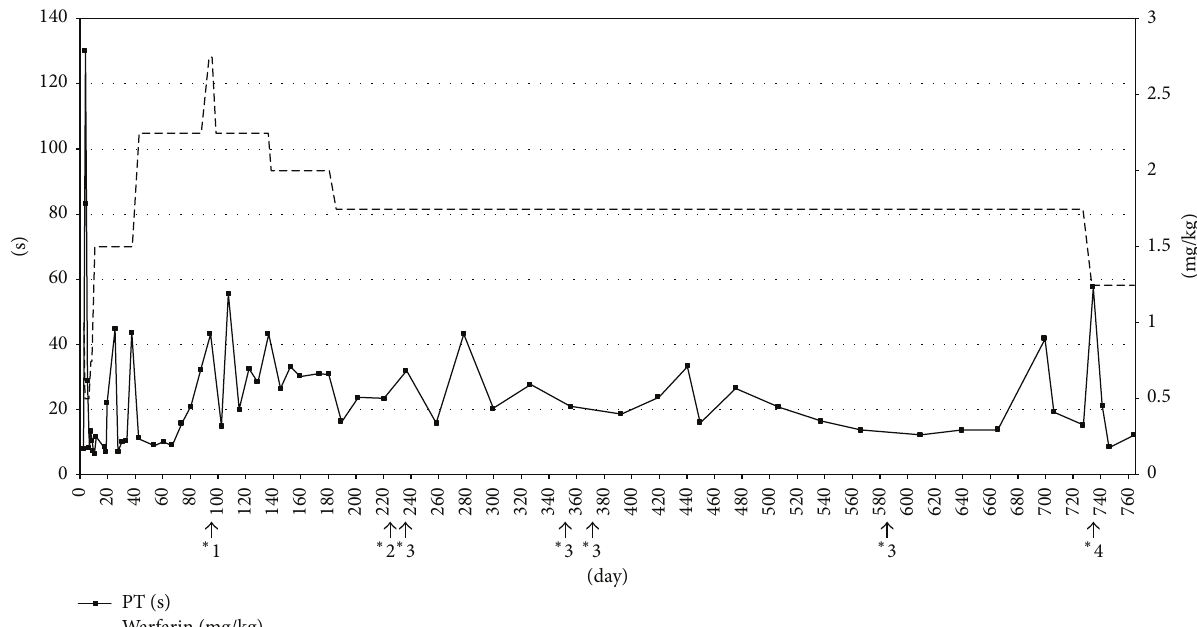
Figure 3: Changes of prothrombin time (PT) and dosage of warfarin administered after operation. ∗ 1 swelling of the right leg and bleeding from the nail root (95 days after operation). ∗ 2 mild paralysis of left leg and mild seizure (226 days after operation). ∗ 3 mild seizure (229, 348, 370, 585 days after operation). ∗ 4 prosthetic valve dysfunction due to thrombus (733 days after operation).